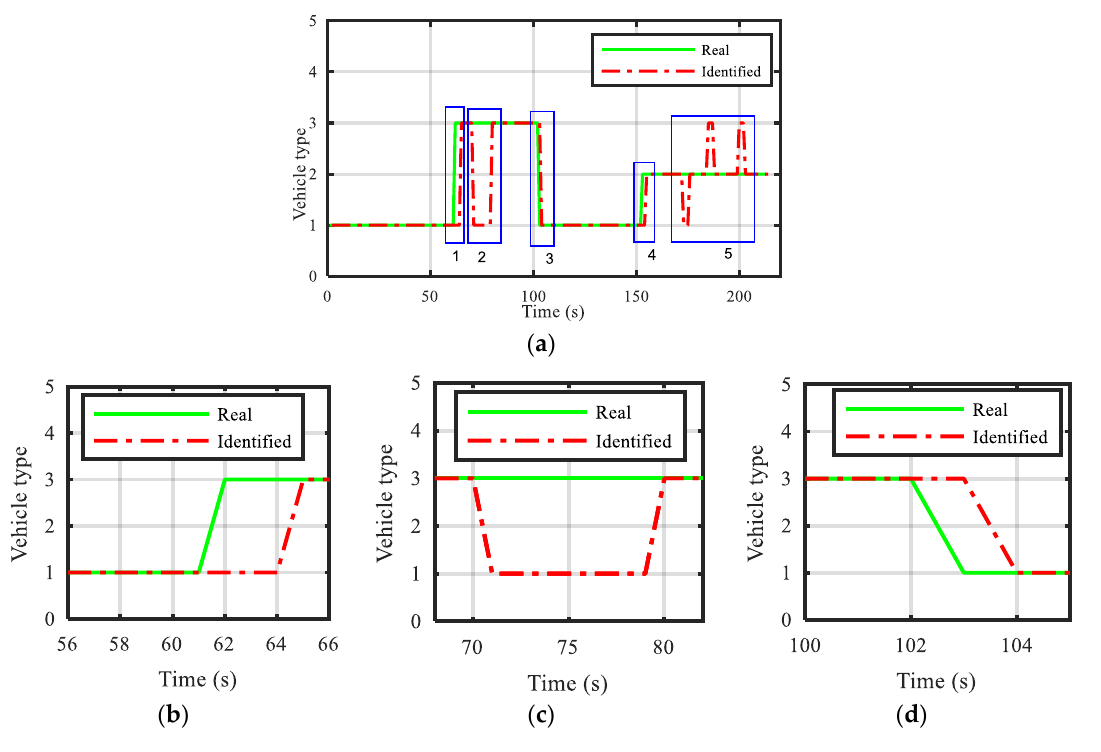
Table 4. Identification accuracy under dynamical